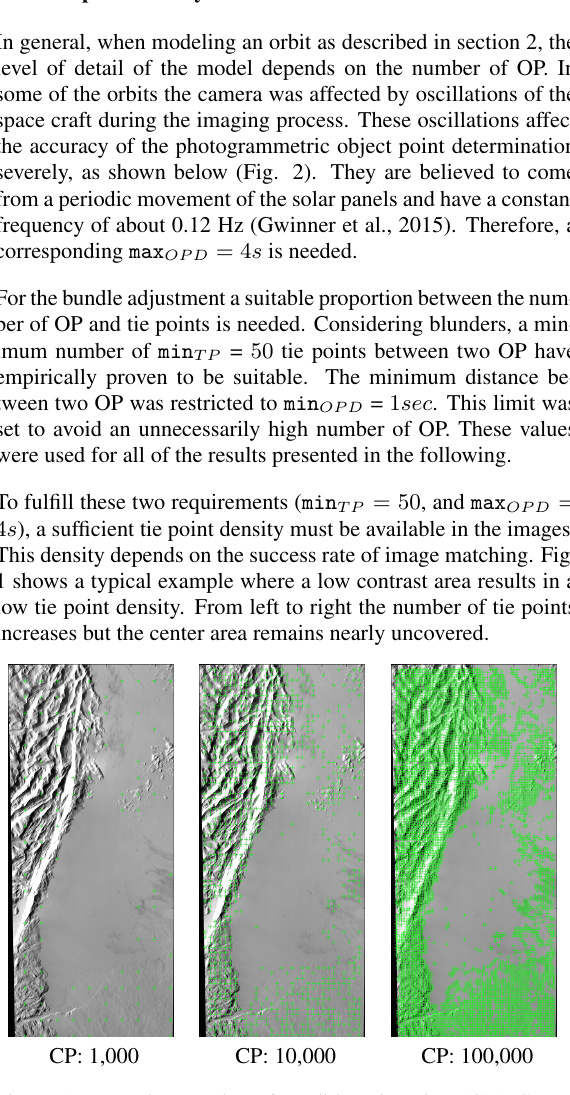
Figure 1: Increasing number of candidate tie points (CP). Green: successfully matched tie points. Background: part of the HRSC nadir image taken in orbit number 3,148 We performed a series of bundle adjustment runs with different numbers of tie points to better understand the general